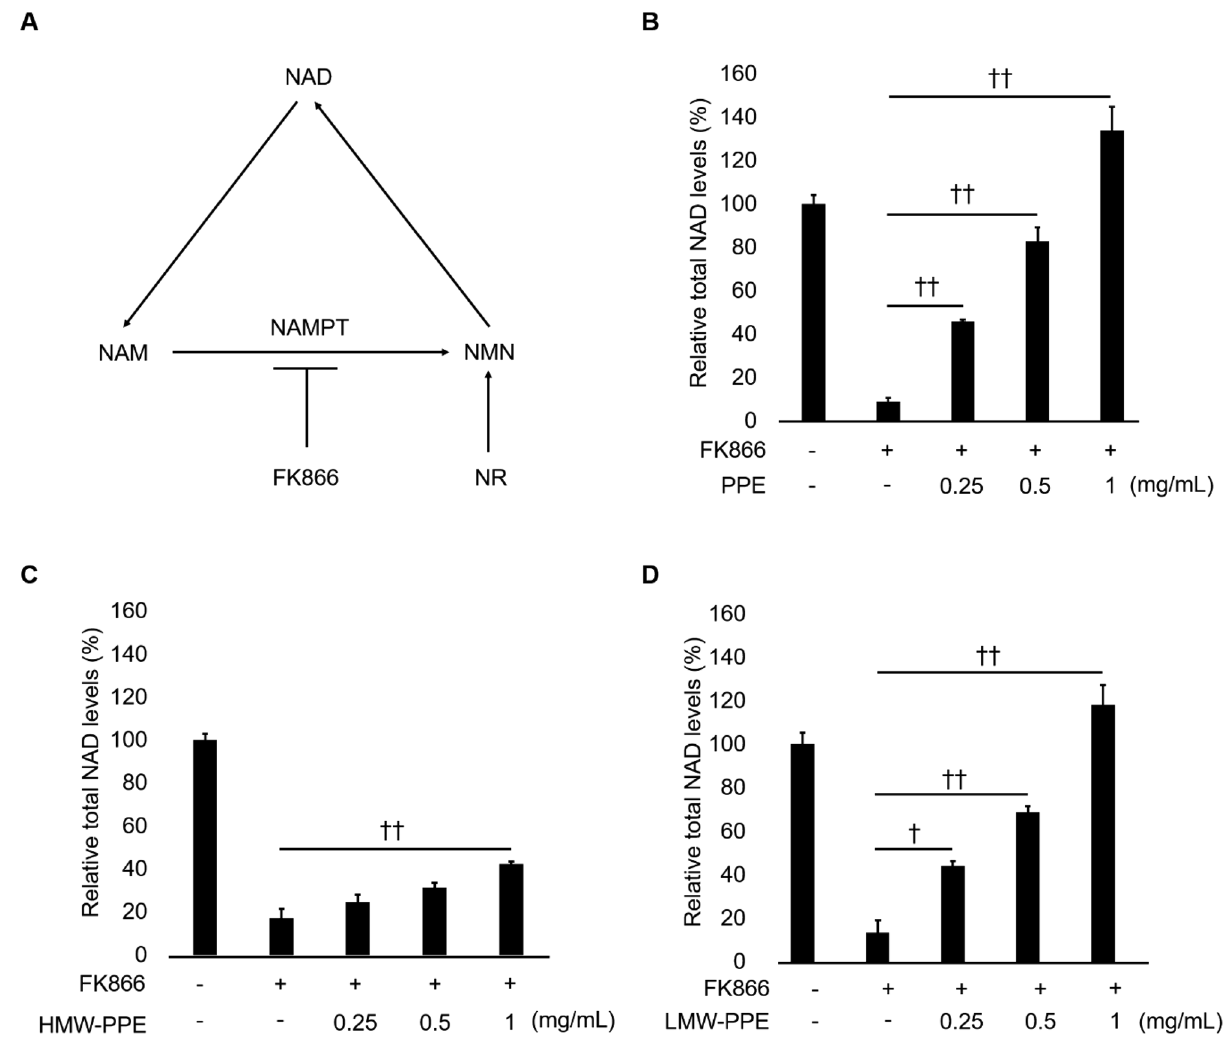
Figure 2. PPE ameliorates the depletion of NAD by FK866 in NHEKs. ( A ) The salvage pathway of NAD biosynthesis. The NHEKs were pre-treated with FK866 for 30 min and incubated with whole-PPE ( B ), HMW- PPE ( C ), or LMW-PPE ( D ) at the indicated concentrations for 24 h. The total NAD levels were determined using NAD + /NADH assay kit. † p < 0.05 and †† p < 0.01, in comparison with the indicated